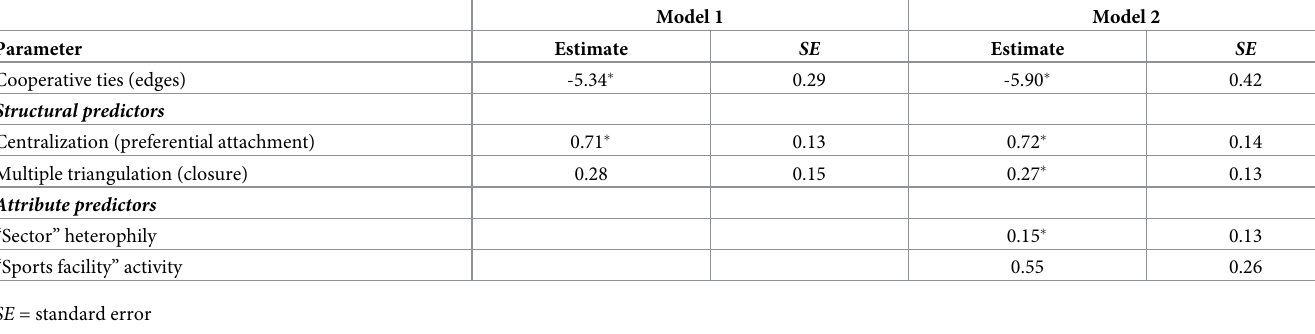
Table 3. ERGM parameter estimates for the PAP network of